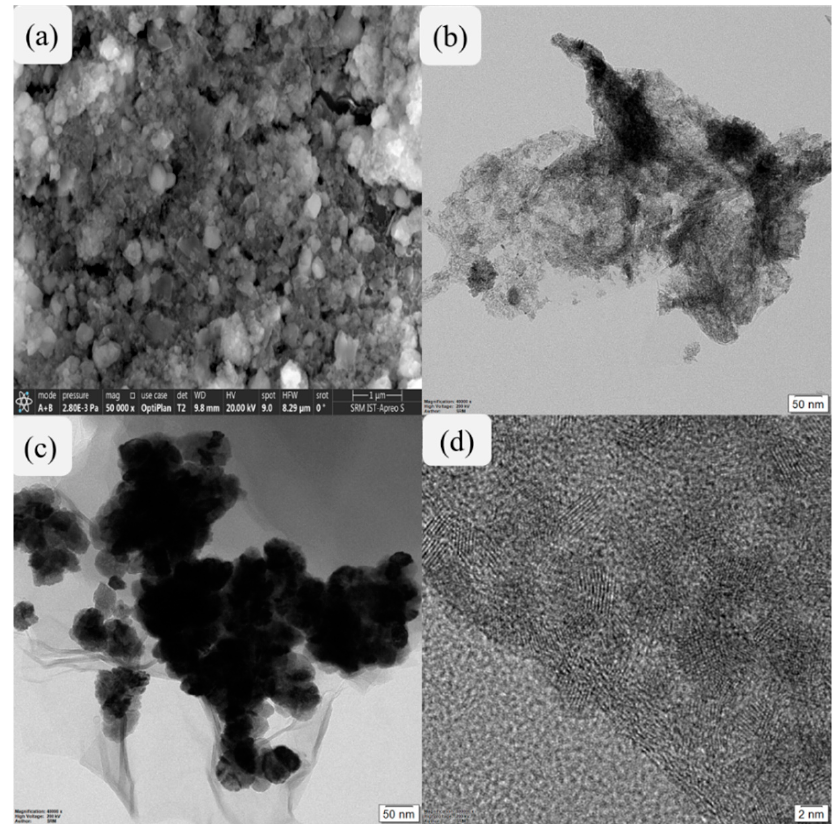
Figure 2. Electron microscopic images of synthesized nanomaterials representing an SEM image of SnO 2 nanoparticles ( a ), TEM image of rGO ( b ), TEM image of SnO 2 @rGO nanocomposite ( c ), and HRTEM image of SnO 2 -rGO nanocomposite ( d ).